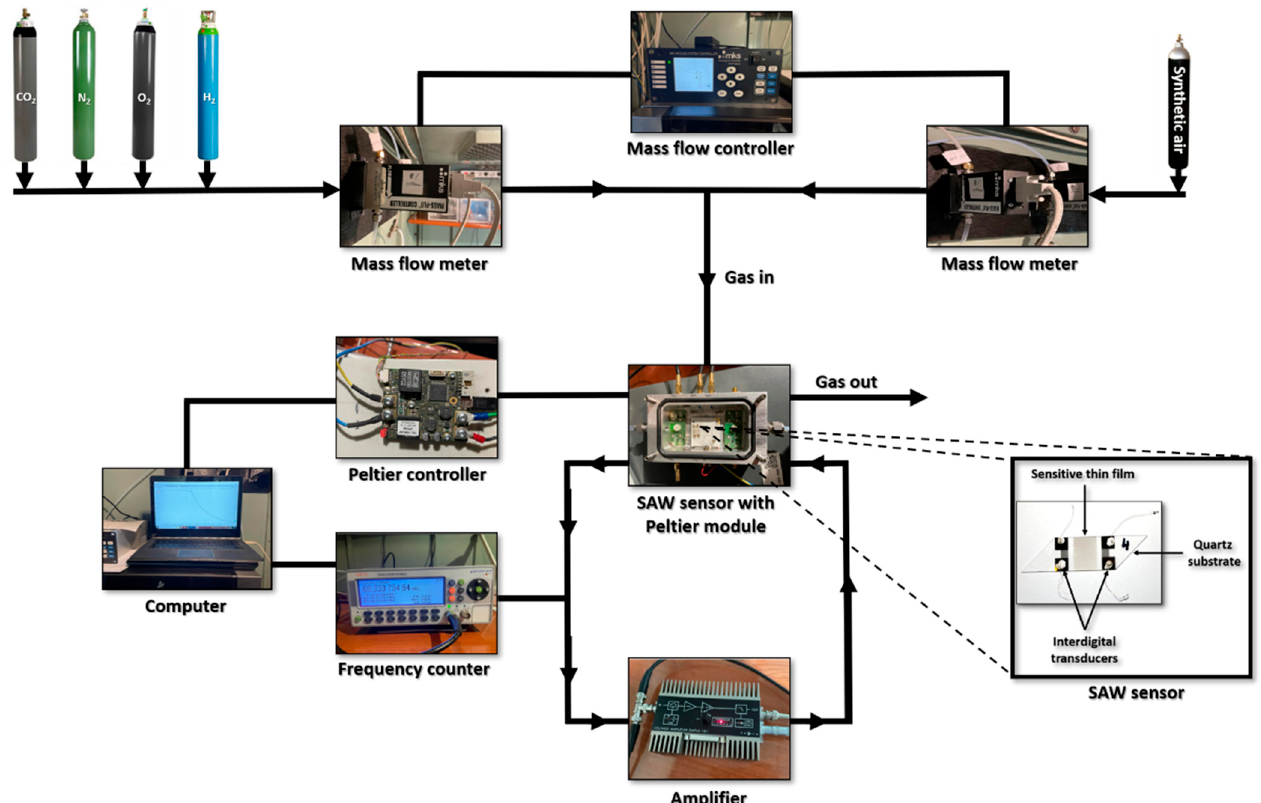
Figure 1. Experimental setup for SAW sensor